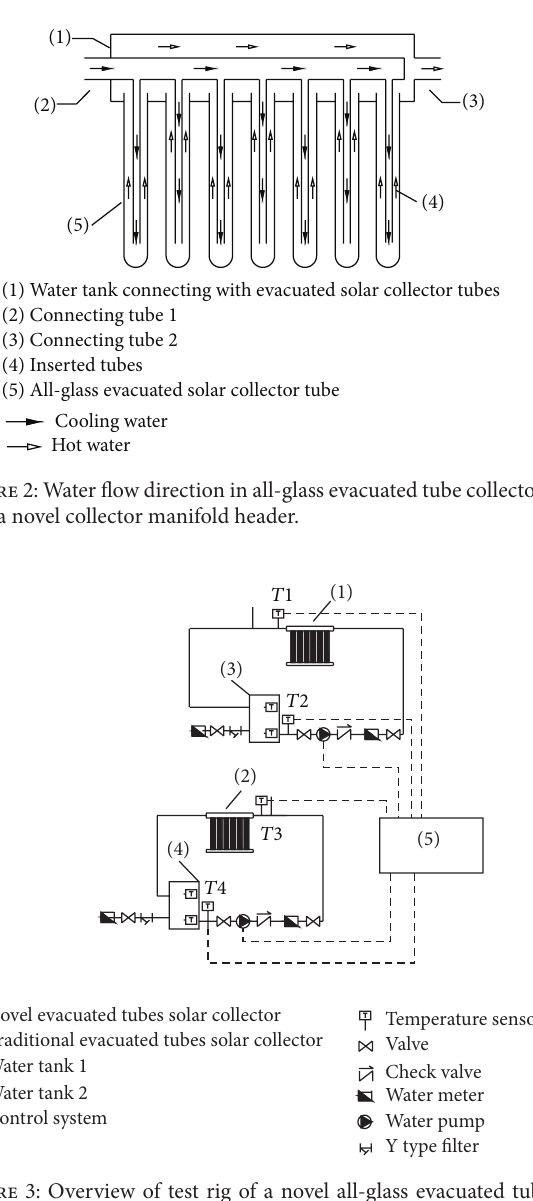
Figure 3: Overview of test rig of a novel all-glass evacuated tube solar collector manifold header with an inserted